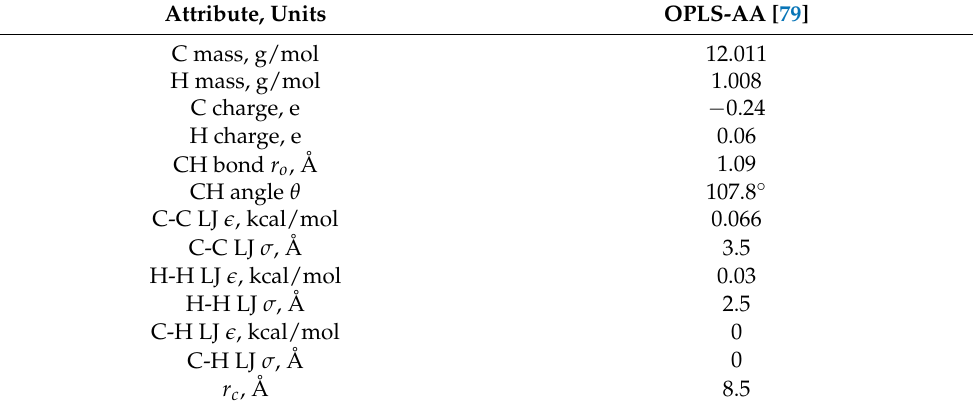
Table 2. LAMMPS force field parameters for OPLS-AA methane